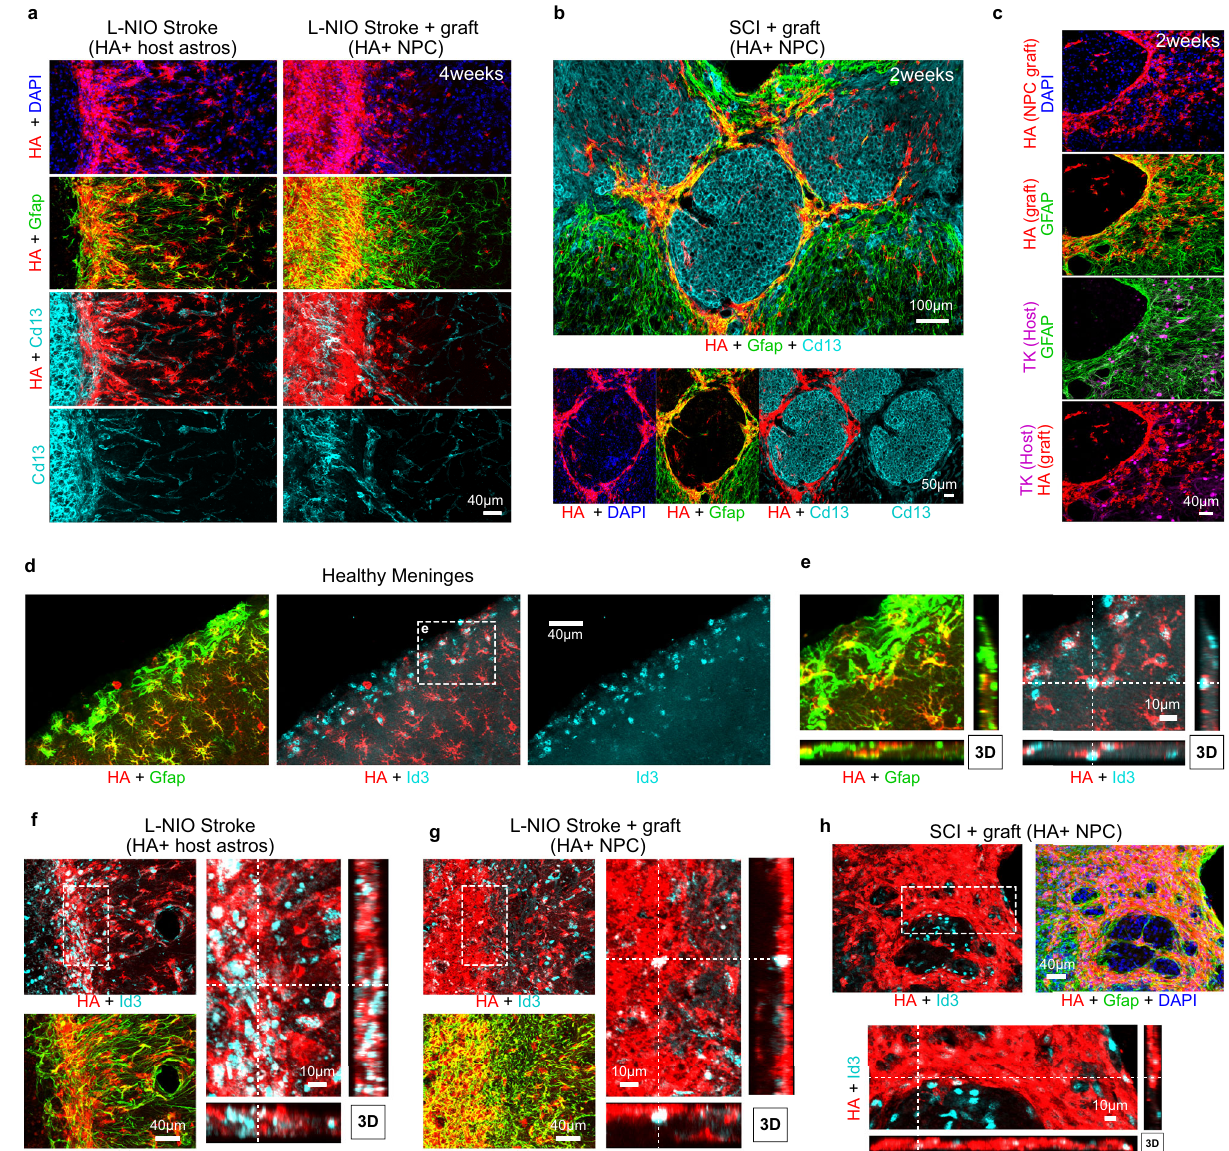
Fig. 6 | Astroglia derivedfromNPCgraftedinto CNS lesionsexhibitfeaturesof border-forming astroglia. a Detailed IHC images showing the astrocyte border phenotype of stroke lesions at 4 weeks in untreated stroke only and NPC grafted strokes. b Survey IHC of NPC grafted SCI lesions at 2 weeks showing NPC-derived astrocyte borders formed around Cd13-positive in fl ammatory cells. c Detailed IHC images showing the astrocyte border phenotype in SCI derived from transplanted NPC and not from host astrocytes (TK-positive). d , e Survey and detailed, higher